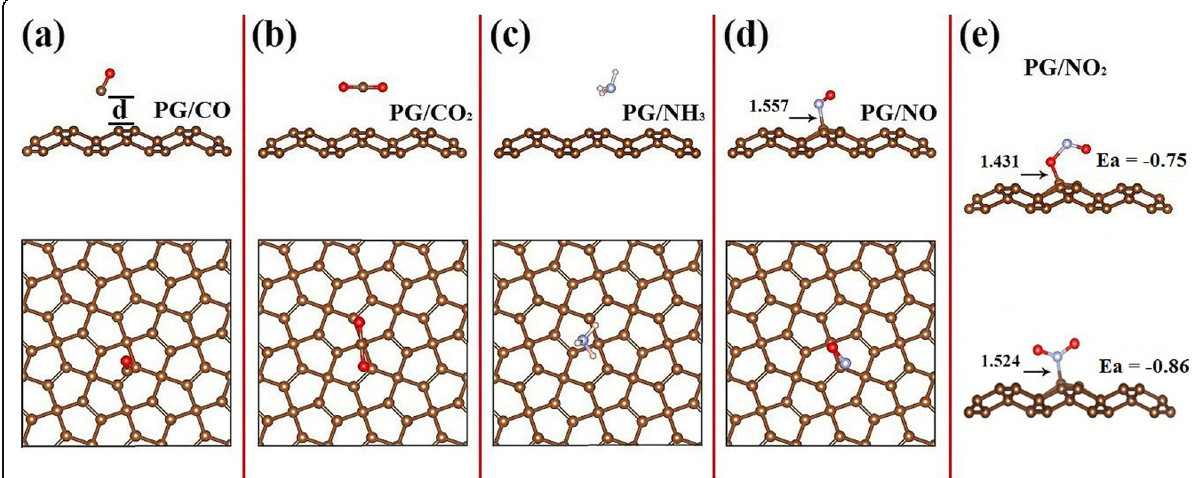
Fig. 1 Adsorption configurations. a – d Side view (top) and top view (bottom) of the fully relaxed structural models of penta-graphene (PG) with CO, CO 2 , NH 3 and NO adsorption, respectively. The last one ( e ) is the side view of the two bonding modes when NO 2 is adsorbed, the binding energy (Ea) has been given. The distance between the gas molecule and the penta-graphene layer is indicated in a and the bond lengths between C and N ( d , e ) and C and O ( e ) at the interface are given (in angstrom units). For simplicity, these structural models are abbreviated as a PG/CO, b PG/CO 2 , c PG/NH 3 , d PG/NO and e PG/NO 2